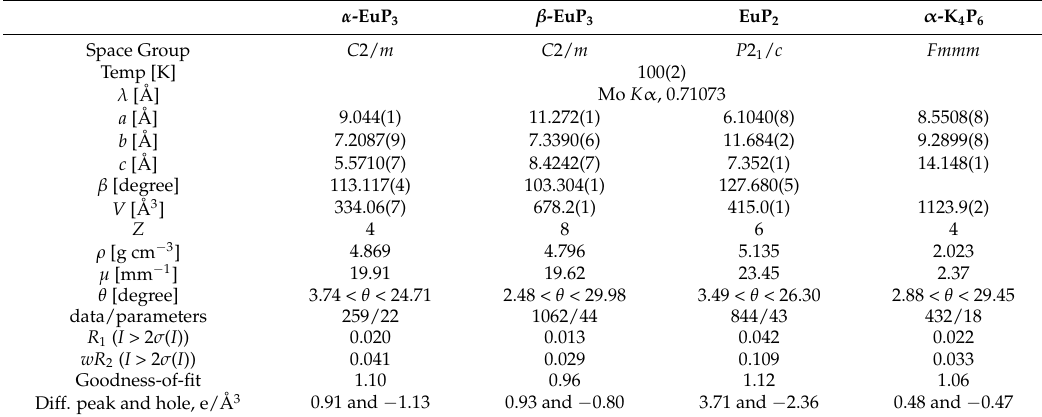
Table 1. Data collection and structure refinement parameters.